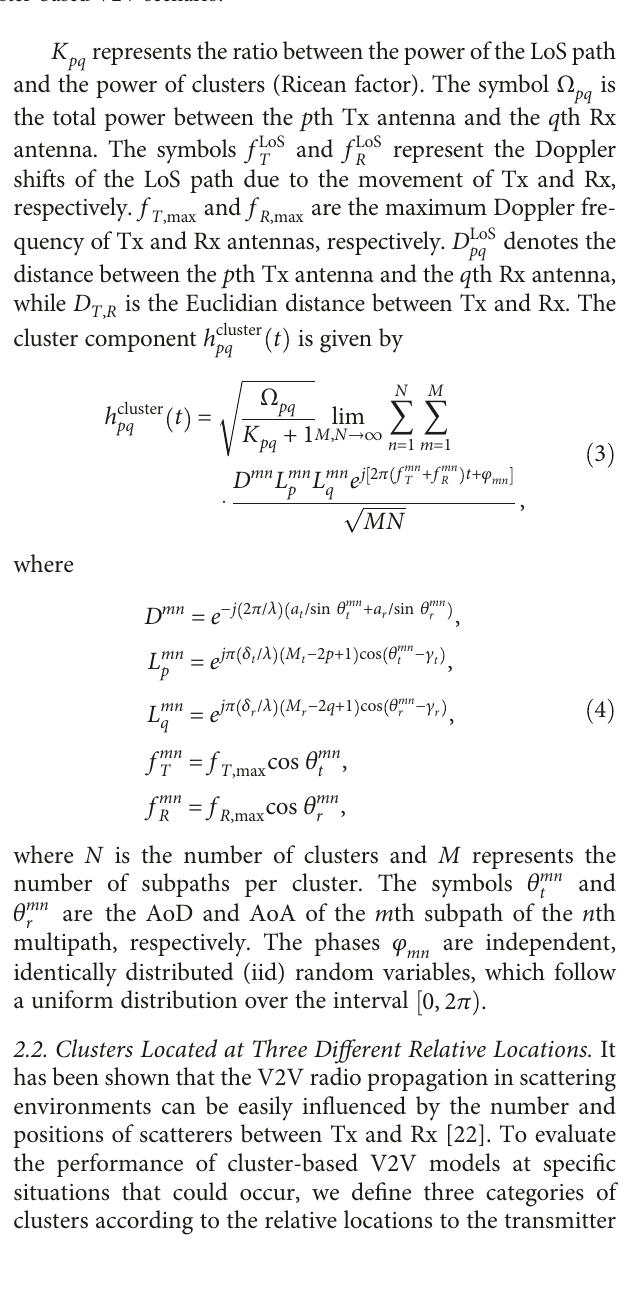
Figure 1: A typical 3D cluster-based V2V